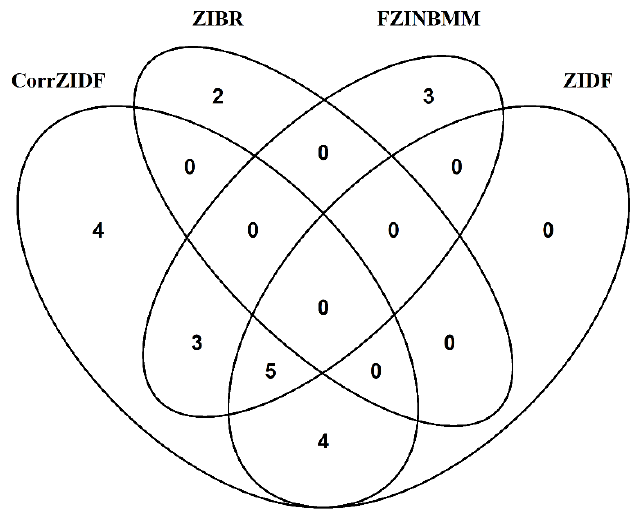
Figure 5. A Venn diagram of the distribution of the significantly differentiated results in the CorrZIDF, ZIDF, ZIBR and FZINBMM in diet dataset. Table 3. List of unique genera by each method for the mouse diet data.